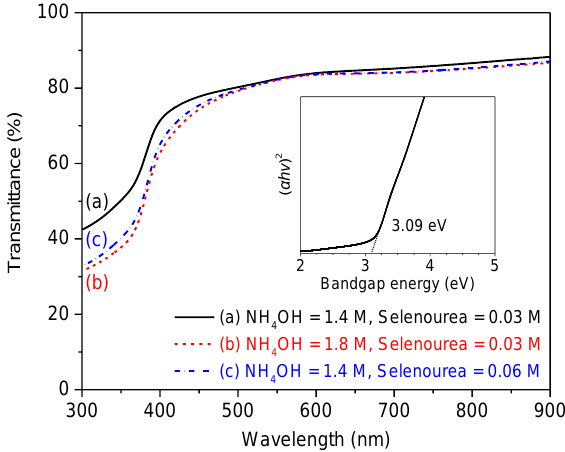
Figure 13. Spectral dependence of optical transmittance for the Zn(Se,OH) films grown on soda-lime glass substrates. Inset is the plot of ( αhν ) 2 versus hν for the Zn(Se,OH) film deposited on the glass substrate.